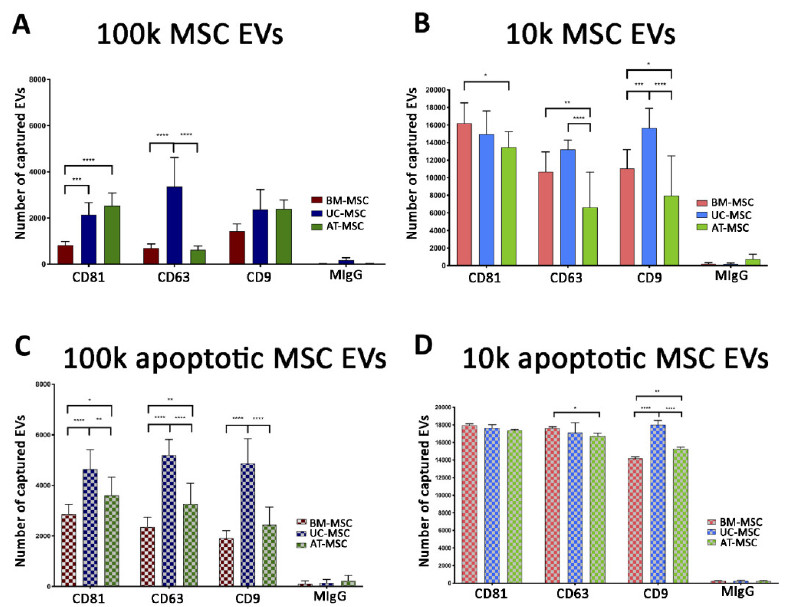
Figure 7. ExoView tetraspanin analysis of 100k and 10k MSC EVs of naive and apoptotic MSCs. Histograms represent the number of captured EVs for CD9, CD63 and CD81 tetraspanins and negative control. 100k MSC EVs ( A , C ) and 10k MSC EVs ( B , D ) isolated from naive ( A , B ) and